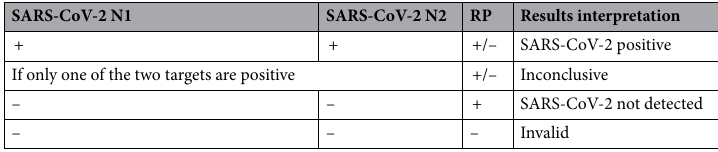
Table 1. Clinical specimen